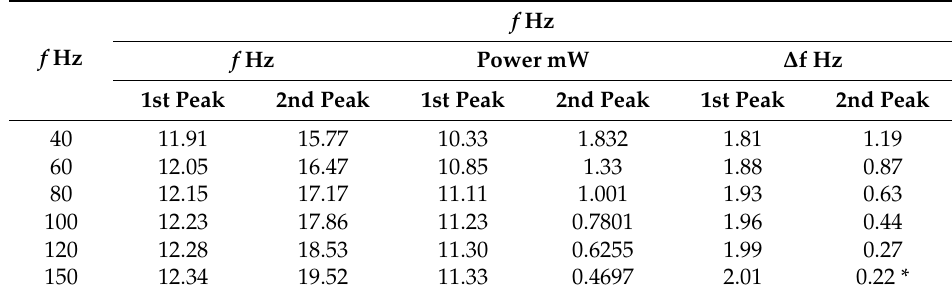
Table A1. Two bimorphs interconnected by a spring system—the influence of the spring constant on the harvested power.